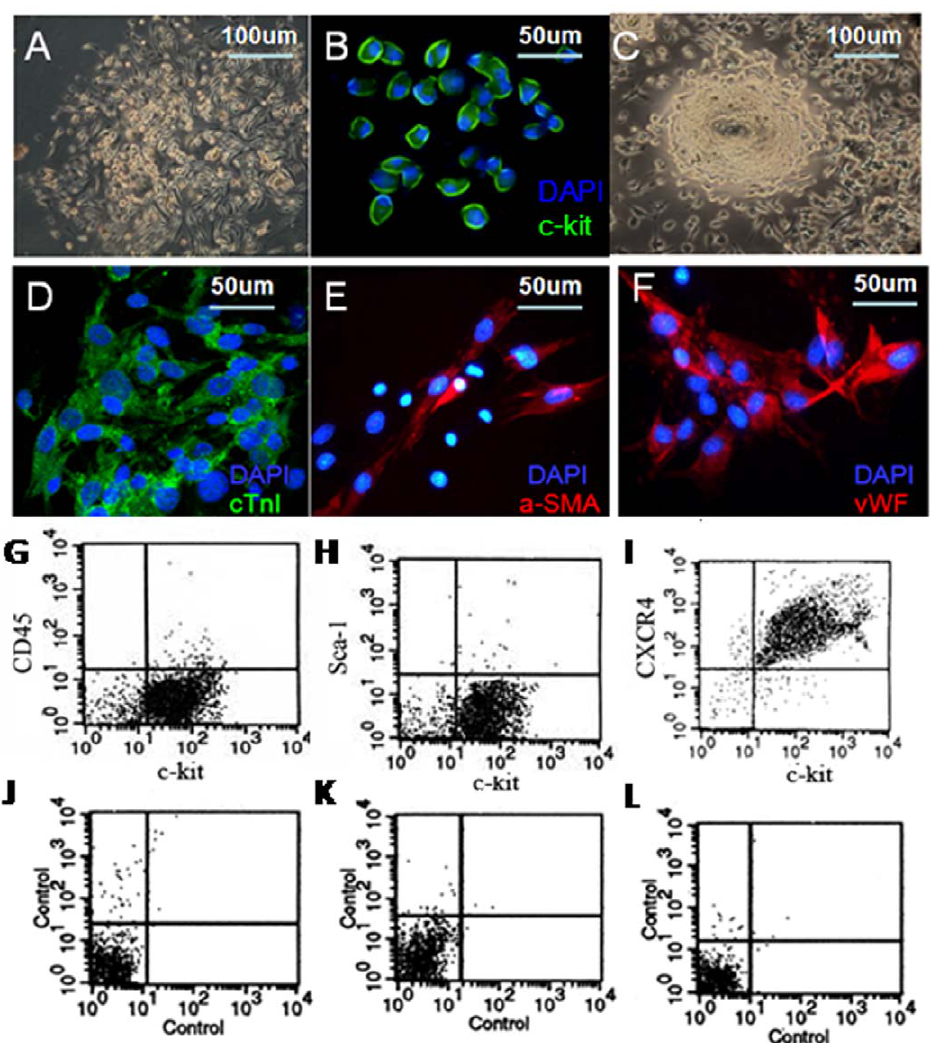
Figure 1. Culture and characterization of c-kit + CSCs. A . small, round, phase-bright cells appeared. B . Purified c-kit + cells were positive for c-kit staining (green). C . Phase-bright cells formed three-dimensional spheres. Multiple differentiation of c-kit + cells into cardiomyocyte ( D , green) smooth muscle ( E , red), and endothelial cells ( F , red). DAPI stained nuclei (blue). FACS analysis of c-kit + cells phenotype with CD45 (4.54% 6 1.79%, G), Sca- 1(2.58% 6 1.16%, H) and CXCR4 (91.47% 6 7.73%, I) (n=3). n =6) (Fig. 4). However, the cells number decreased in AMD3100 expression in infarcted myocardium (SDF-1 a vs. MI, 2.22 6 0.38 (7.7 6 1.7, p , 0.01 vs. SDF-1 a ) and LY294002 group (7.9 6 0.9, vs. 1.20 6 0.19, p , 0.01, SDF-1 a vs. Empty, 2.22 6 0.38 vs. 1.30 6 0.17, p , 0.01) at day 21. There was no difference among SDF-1 a , AMD3100 and LY294002 groups (2.22 6 0.38 vs. 2.08 6 0.25 and 2.02 6 0.31, p . 0.05, n= 3) (Fig. 3A). Immunofluorence staining showed more CSCs in the infarcted regions in SDF-1 a group (SDF-1 a vs. Empty, 30.3 6 6.5 vs. 10.3 6 2.5, p , 0.01 n= 6). However, the number of CSCs decreased in AMD3100 (AMD3100 vs. SDF-1 a , 8.7 6 1.5 vs. 30.3 6 6.5, p , 0.01) and LY294002 group (LY294002 vs. SDF-1 a , 8.0 6 2.0 vs. 30.3 6 6.5, p , 0.01) (Fig. 3B). Proliferation and differentiation of transplanted CSCs Proliferation of transplanted CSCs was determined by Brdu/ DAPI double staining. Immunofluorence staining showed more BrdU positive cells in the infarcted regions in SDF-1 a group than Empty group (SDF-1 a vs. Empty, 28.8 6 1.5 vs. 8.9 6 1.8, p , 0.01